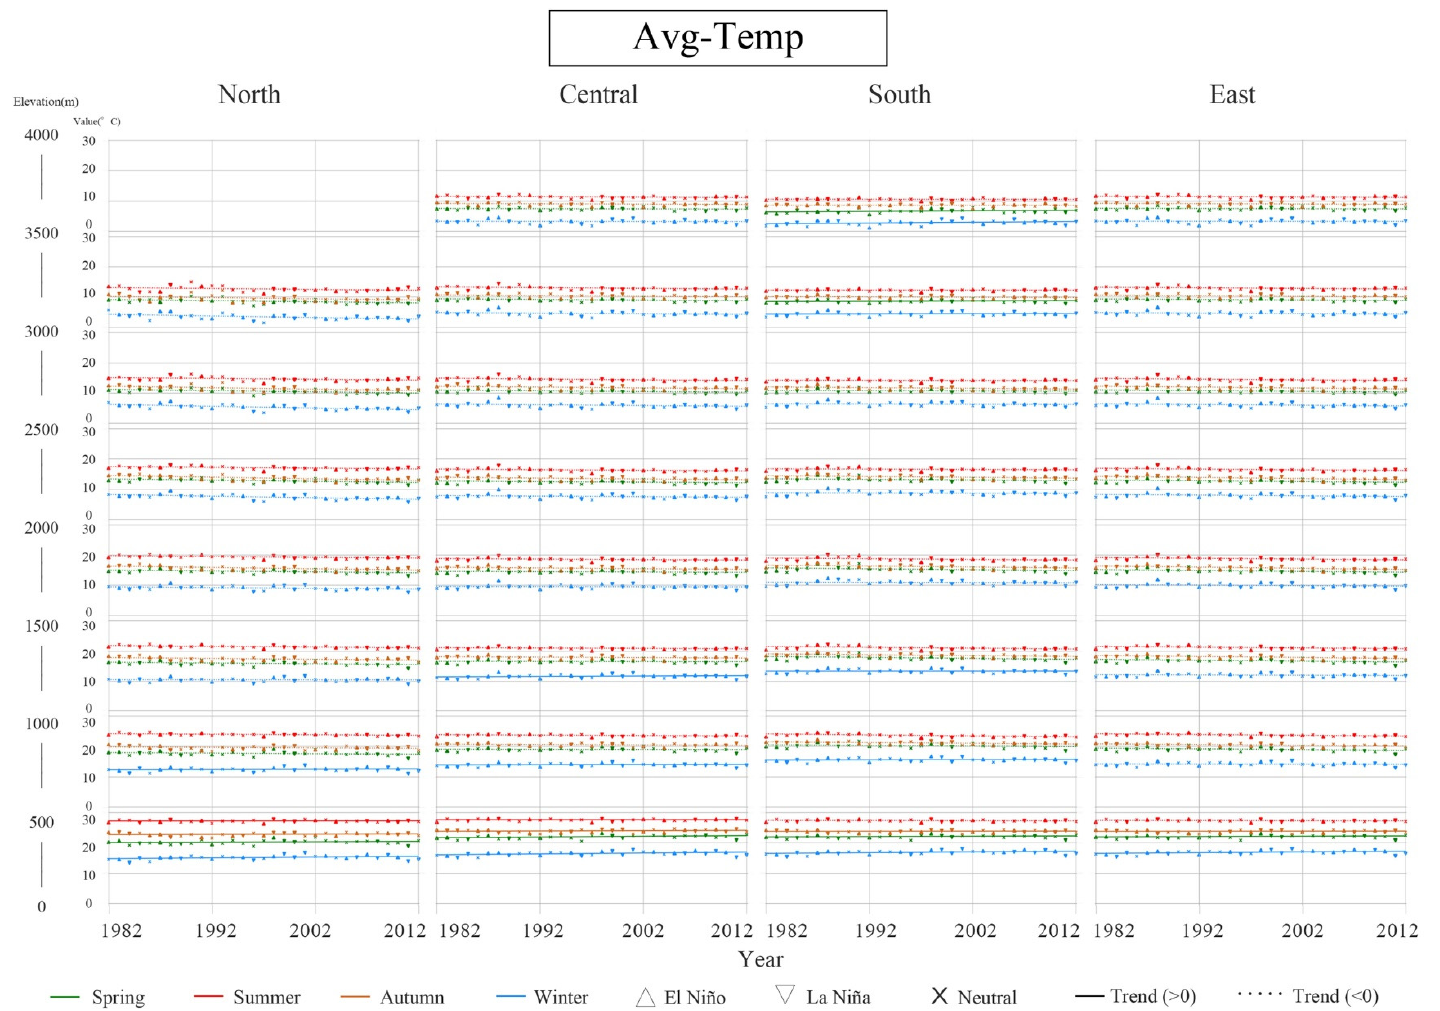
Figure 11. Regional and seasonal linear regression results for the average temperature at varied elevations.